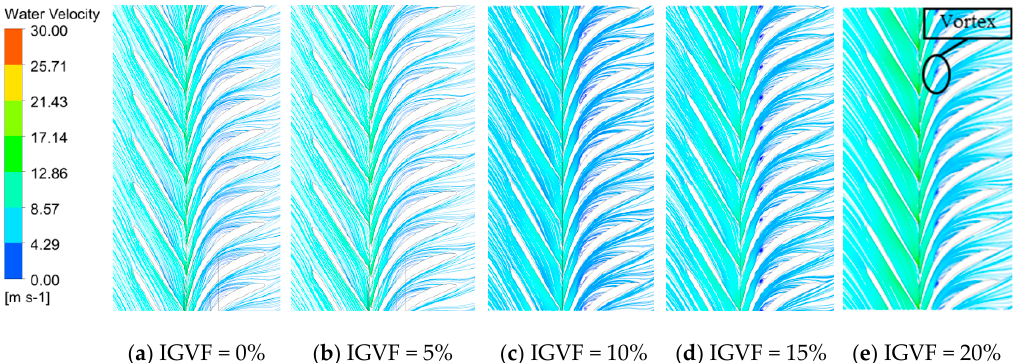
Figure 12. Streamline distribution in the second-stage compression unit with different IGVFs.